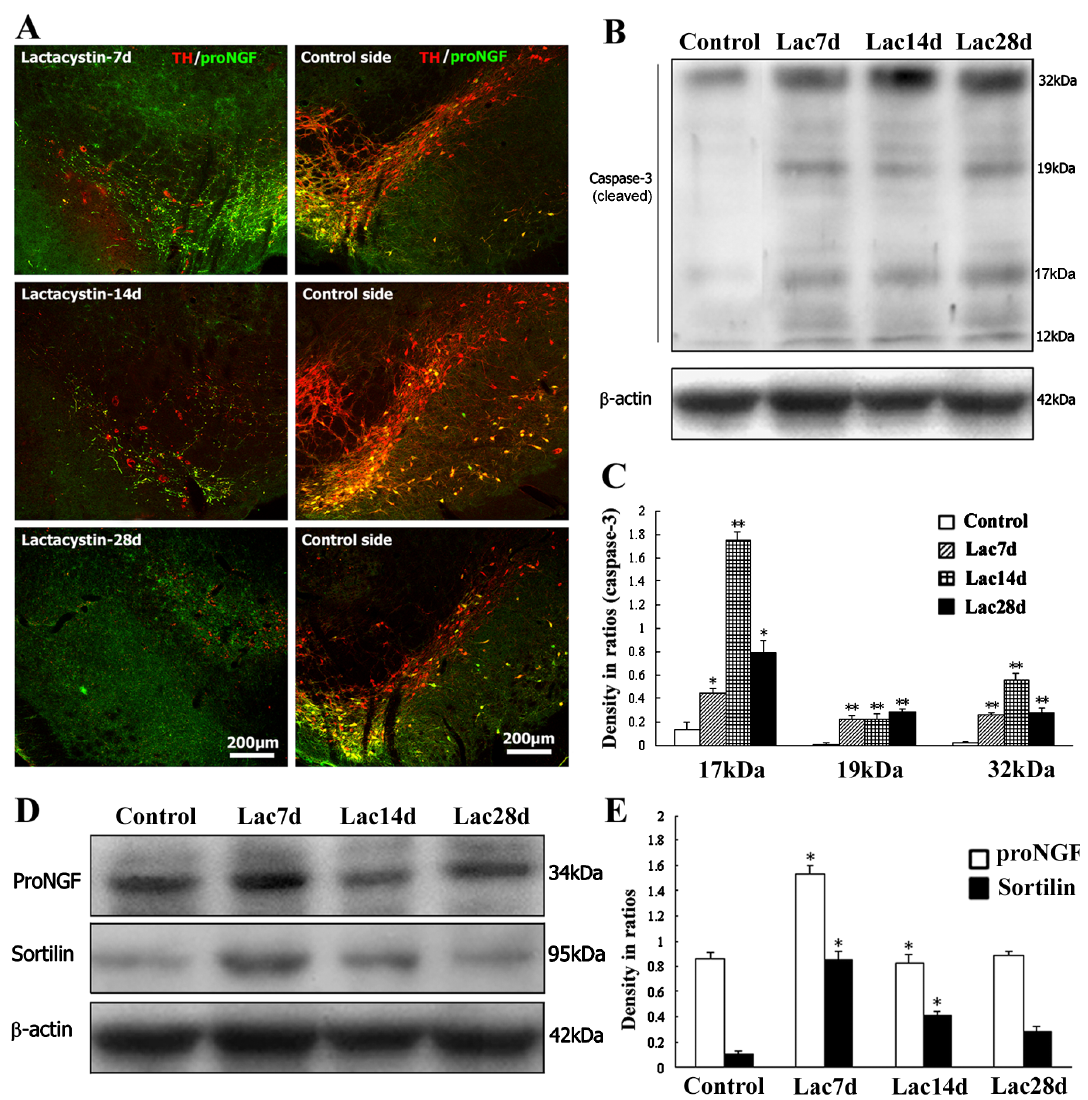
Figure 6. The proNGF-containing dopamine neurons in the substantia nigra show vulnerability to lactacystin insult. ( A ) The proNGF/TH double-labeled neurons exist numerously in the control nigral side, while they died off mostly at 7 days, or completely at 14 days and 28 days in the lesioned side; ( B ) Immunoblotting of active caspase-3 in the substantia nigra of the lactacystin model; ( C ) Comparison of cleaved caspase-3 (17 kDa, 19 kDa, 32 kDa) expression among control, lac7 days, lac14 days and lac28 days; ( D ) Immunoblotting of proNGF and sortilin in the substantia nigra of rat lactacystin model; and ( E ) Comparison of proNGF and sortilin expression levels among control, lac7 days, lac14 days and lac28 days. ANOVA test: * p < 0.005, ** p < 0.001, vs. control or earlier time-point of lactacystin